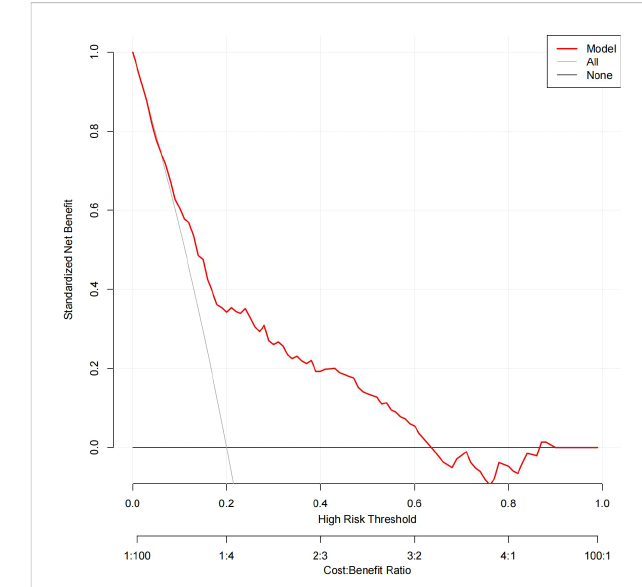
FIGURE 8 The DCA of the model using LR. DCA, decision curve analysis; LR, logistic regression.